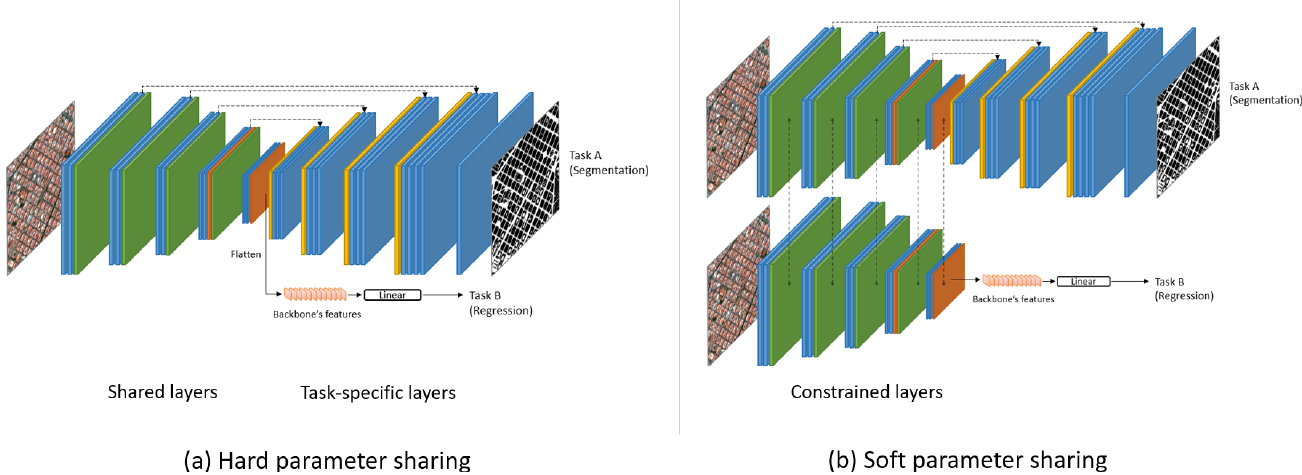
Figure 4. Multi-task architectures depending on how the parameters of the hidden layers are